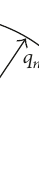
Figure 6: Spherical linear